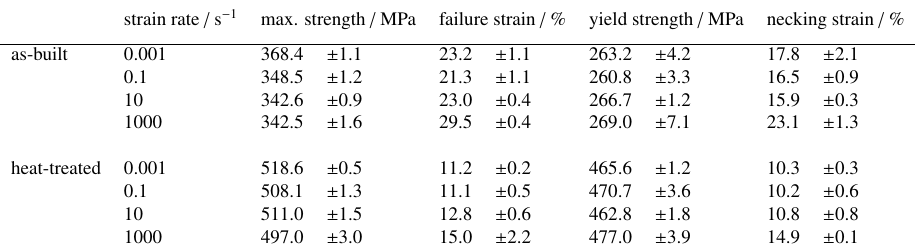
Table 1. Results for ultimate tensile strength σ max , failure strain ε fail , yield strength and necking strain at di ff erent strain rates considered in this work. Errors indicate one standard